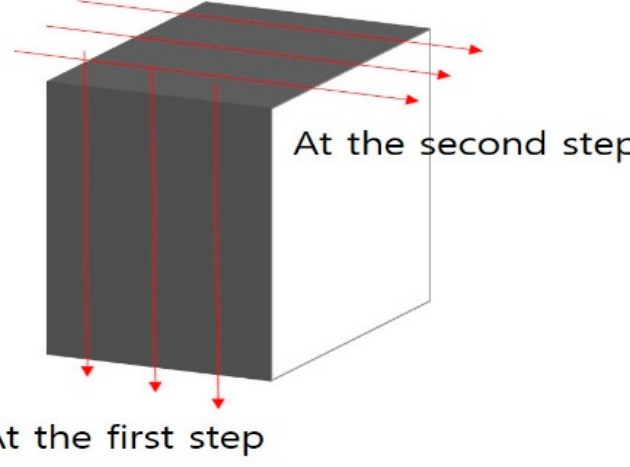
Figure 2. Dimension reduction in the 3-D PCA method.